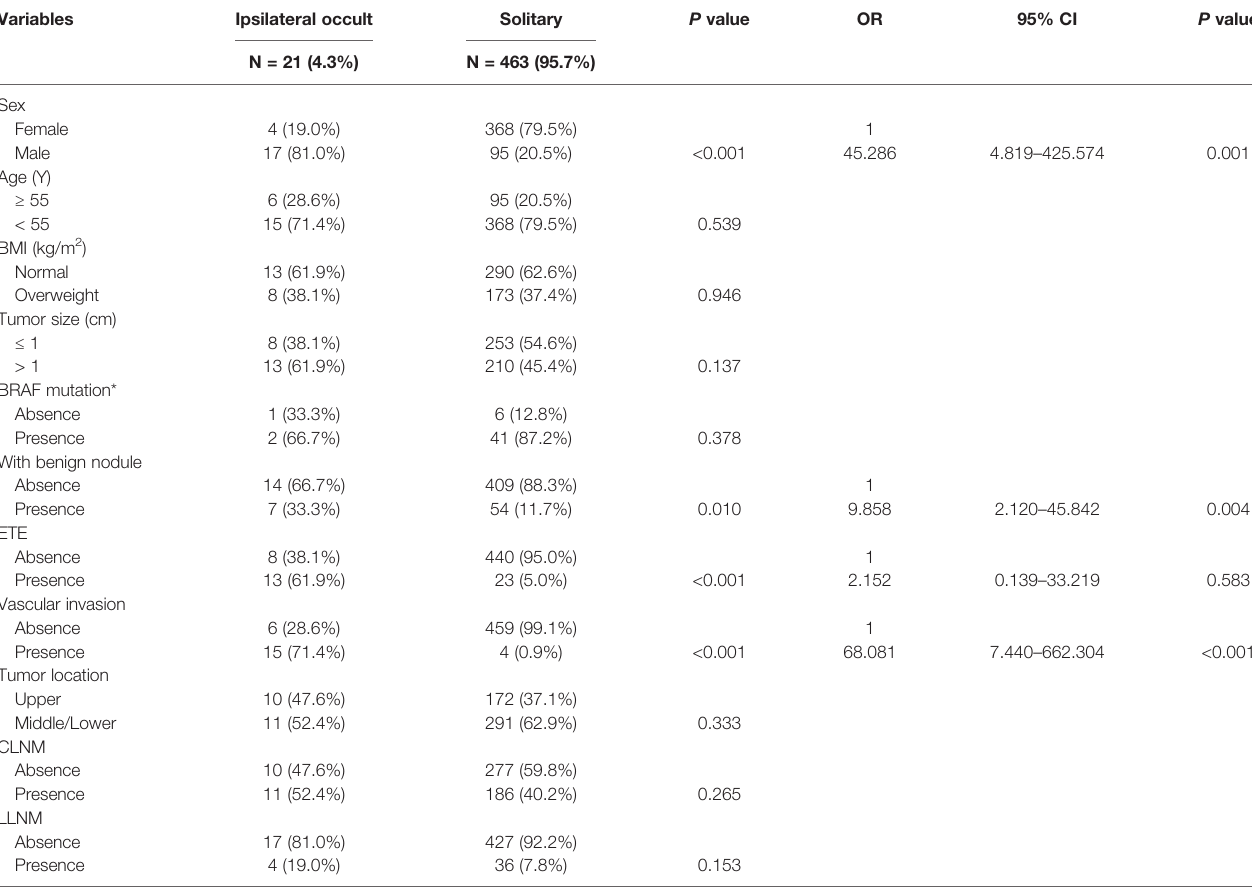
TABLE 3 | Associations between clinicopathological characteristics and ipsilateral occult carcinoma in PTC patients.